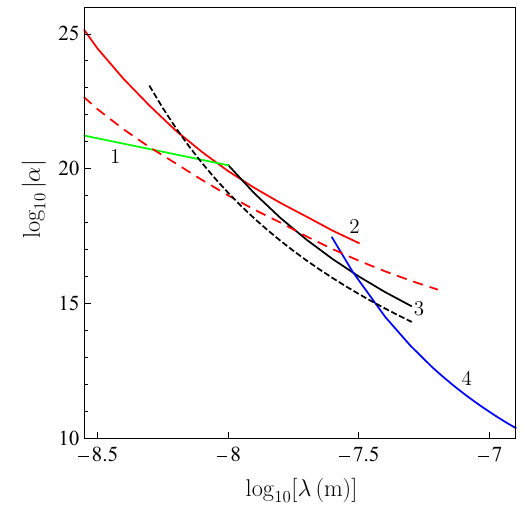
Fig. 1 Constraints on the parameters of Yukawa-type correction to Newton’sgravitationallawobtainedin[10]fromtheexperimentonneu- tron scattering ( line 1 ), in [8] from measuring the lateral Casimir force [23,24]( line2 ),in[9]frommeasuringthenormalCasimirforce[25,26] ( line3 ),andin[21]fromtheisoelectronicCasimir-lessexperiment( line 4 ). The long-dashed and short-dashed lines show the prospective con- straints obtained in this work (see the text for further discussion). The regions of the plane below each line are allowed and above each line are